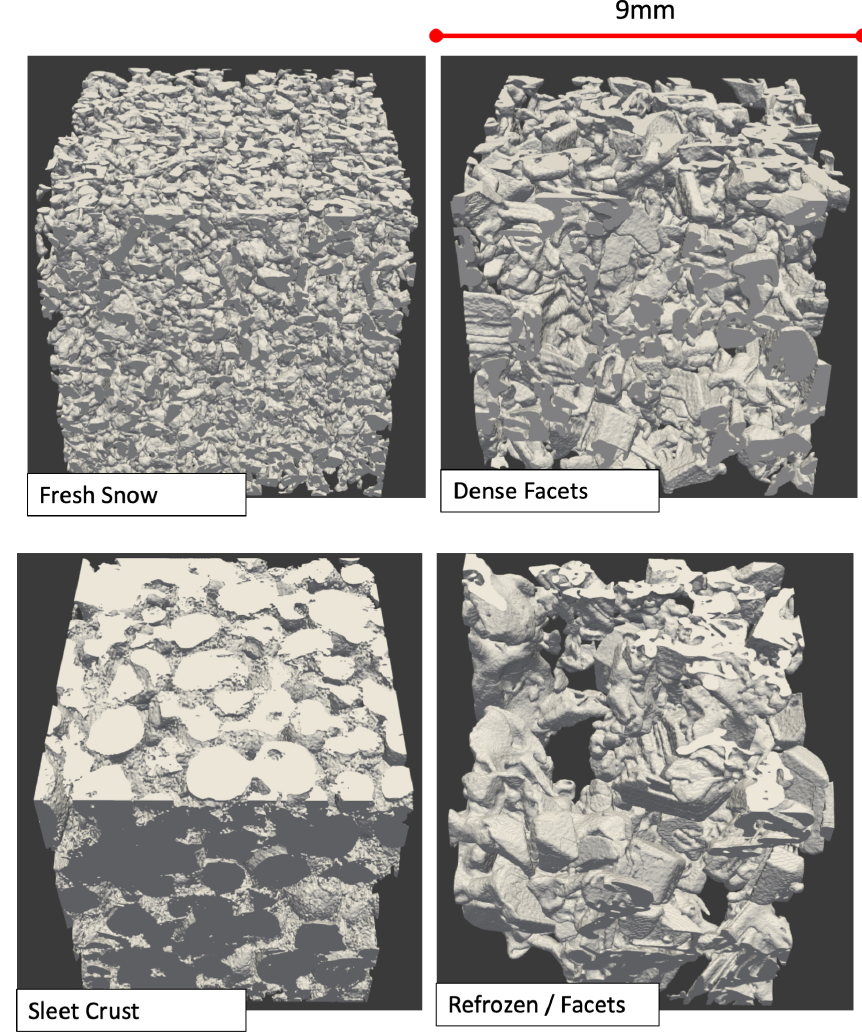
Figure 6. Example 3D renderings of selected µCT samples representing different types of snow grain.